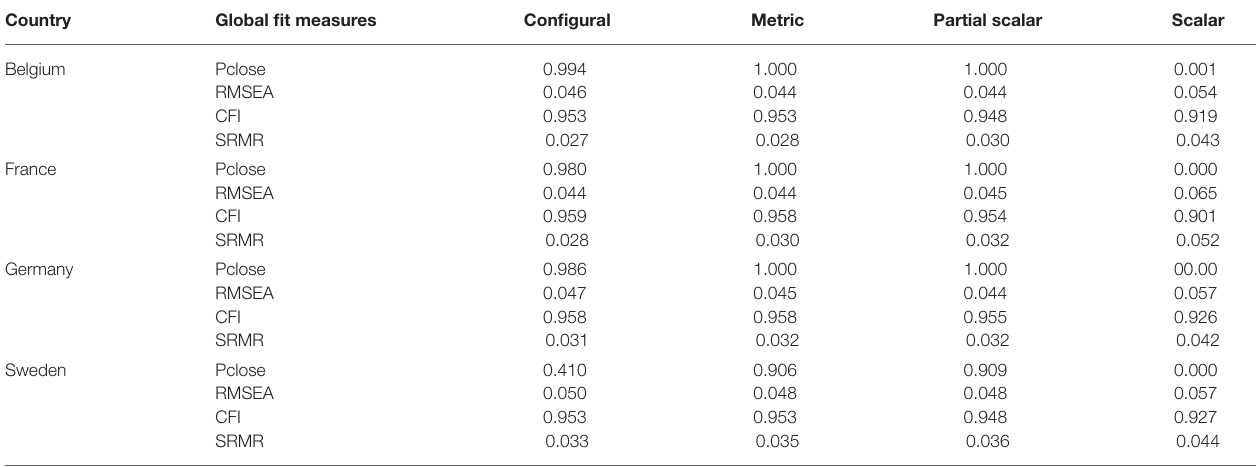
TABLE 2 | Fit measures for the different levels of measurement invariance. Country Global fit measures Configural Metric Partial scalar Scalar